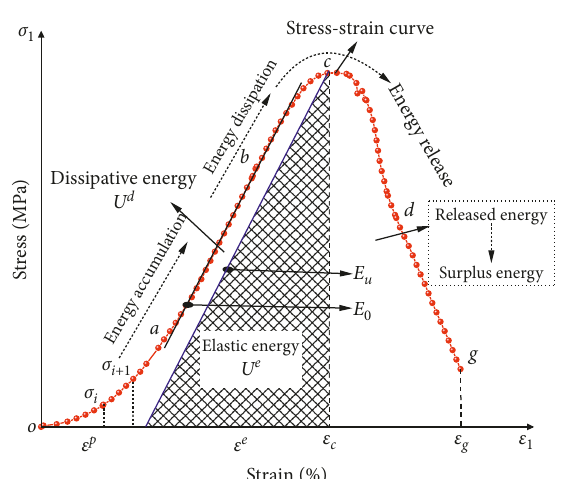
Figure 1: Relationship between the release of elastic energy and dissipated energy in the